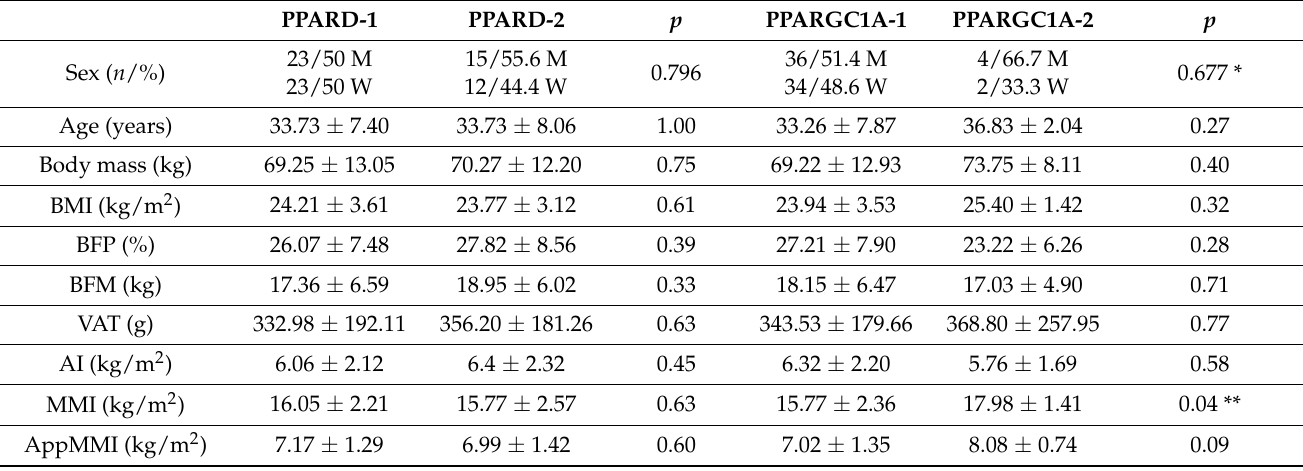
Table 2. Age, sex and body composition parameters of participants according to their